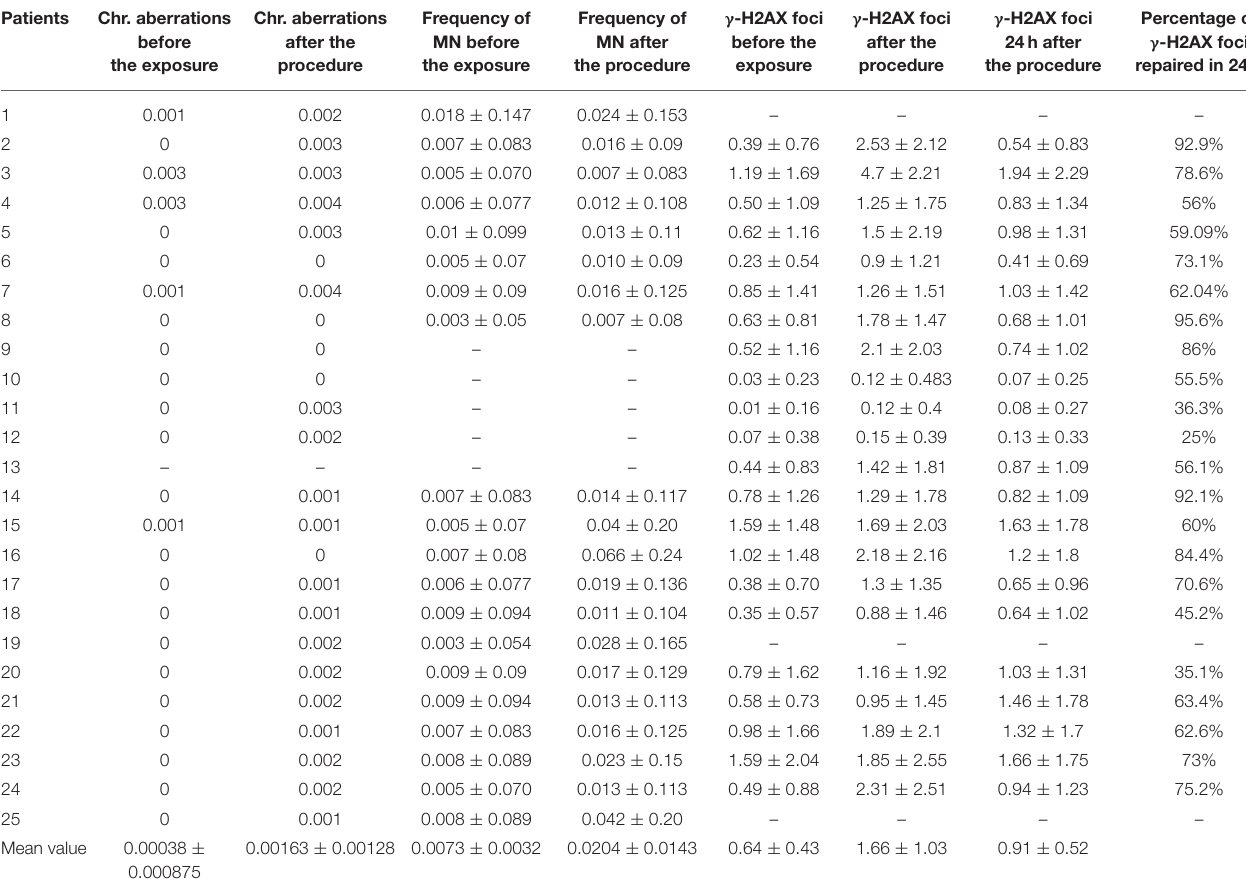
TABLE 1 | Mean values of chromosomal aberrations, frequency of Micronuclei (MN), and γ -H2AX foci per cell before the exposure, immediately after the interventional procedure ( in vivo radiation), and 24h later, as well as the percentage of γ -H2AX foci repaired at 24h.